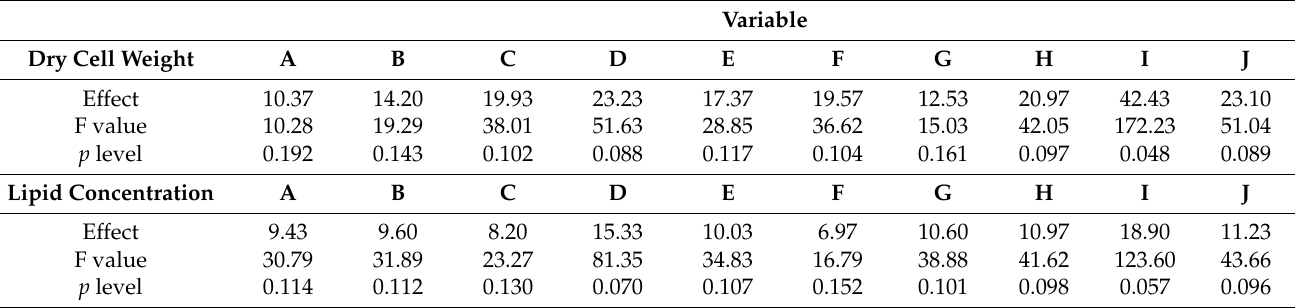
Table 8. Effect of the tested variable on the growth of dry cell weight and lipids in S. limacinum E20 culture, with the corresponding statistical